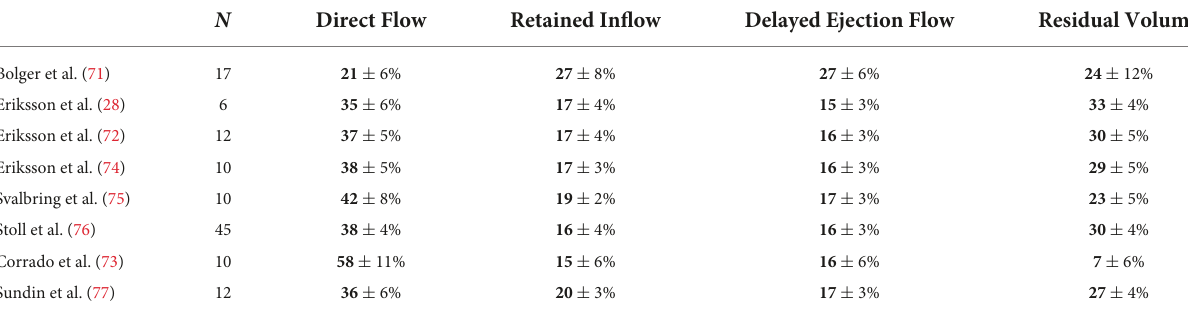
TABLE 4 Flow components as percentage of LVEDV in healthy